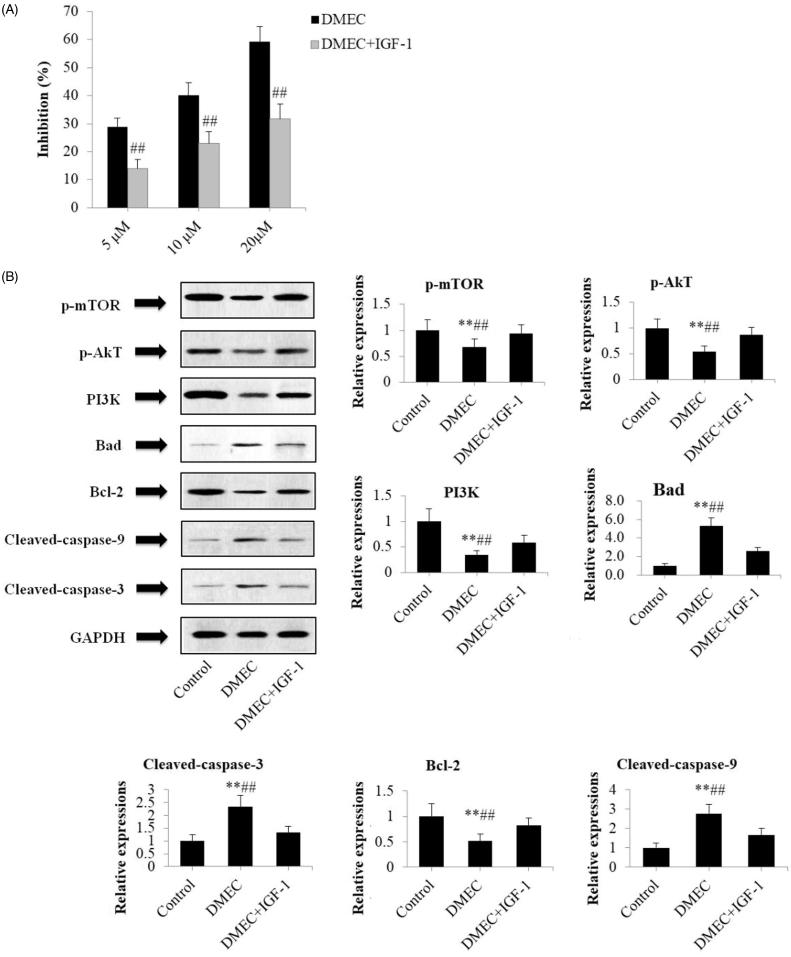
Pretreatment with IGF-1 decreased DMEC mediated apoptosis in U266 cells. (A) CCK-8 assay. U266 cells were treated with IGF-1 (100 ng/mL) for 1 h, followed by co-culture with DMEC (5, 10, and 20 μM) for 24 h. Subsequently, CCK-8 assay was used to determine the cell proliferation inhibition rate (n = 4). (B) Western blotting analysis. U266 cells were treated with IGF-1 (100 ng/mL) for 1 h, followed by co-culture with DMEC at 20 μM for 24 h. Protein expression levels were determined by western blotting analysis with the antibodies against p-mTOR, p-Akt, PI3K, Bad, Bcl-2, C-3 and C-9. Data are presented as the mean ± standard deviation (n = 4). **p < 0.01 vs. control group; ##p < 0.01 vs. DMEC + IGF-1 group.